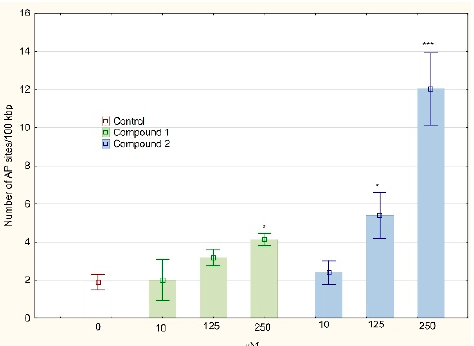
Figure 8. Abasic sites’ (AP) number per 100 kbp in DNA of MKN74 cells treated with compound 1 or 2 for 24 hours. The AP site detection was based on a specific reaction of an aldehyde-reactive probe (ARP) with an aldehyde group present on the open-ring form of AP sites. AP sites were tagged with biotin residues and were quantified using avidin-biotin assay followed by colorimetric detection of peroxidase conjugated to the avidin at 650 nm. Values were presented as mean ± SD. *p < 0.05, ***p<0.001 vs. control; (ANOVA followed by Tukey’s HSD post hoc analysis).